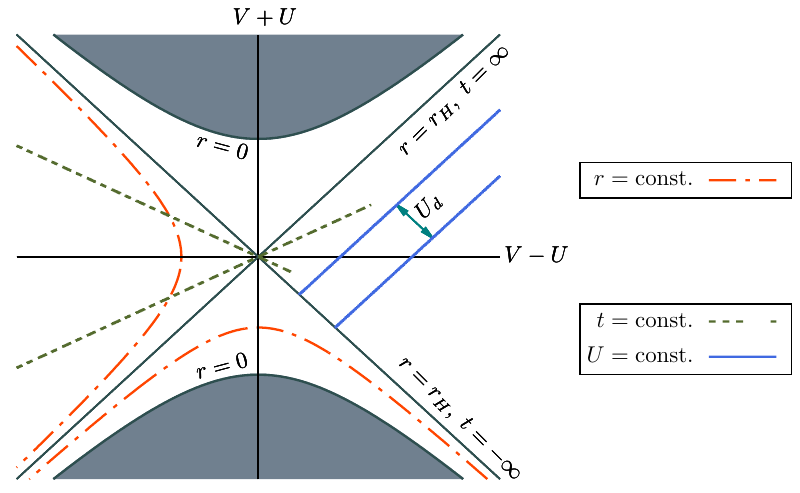
Figure 1 . Schematic representation of two detectors in outgoing null paths depicted in a Kruskal diagram. In Eddington-Finkelstein coordinates the two detectors are separated as u while in Kruskal coordinates they are separated as U U j = − 2 r H e − u j / 2 r H